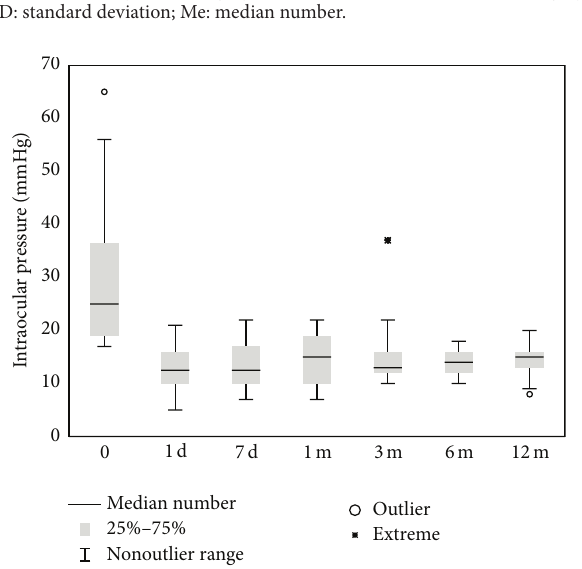
Figure 1: Median number, outlier, and extreme of intraocular pressure at specific time after